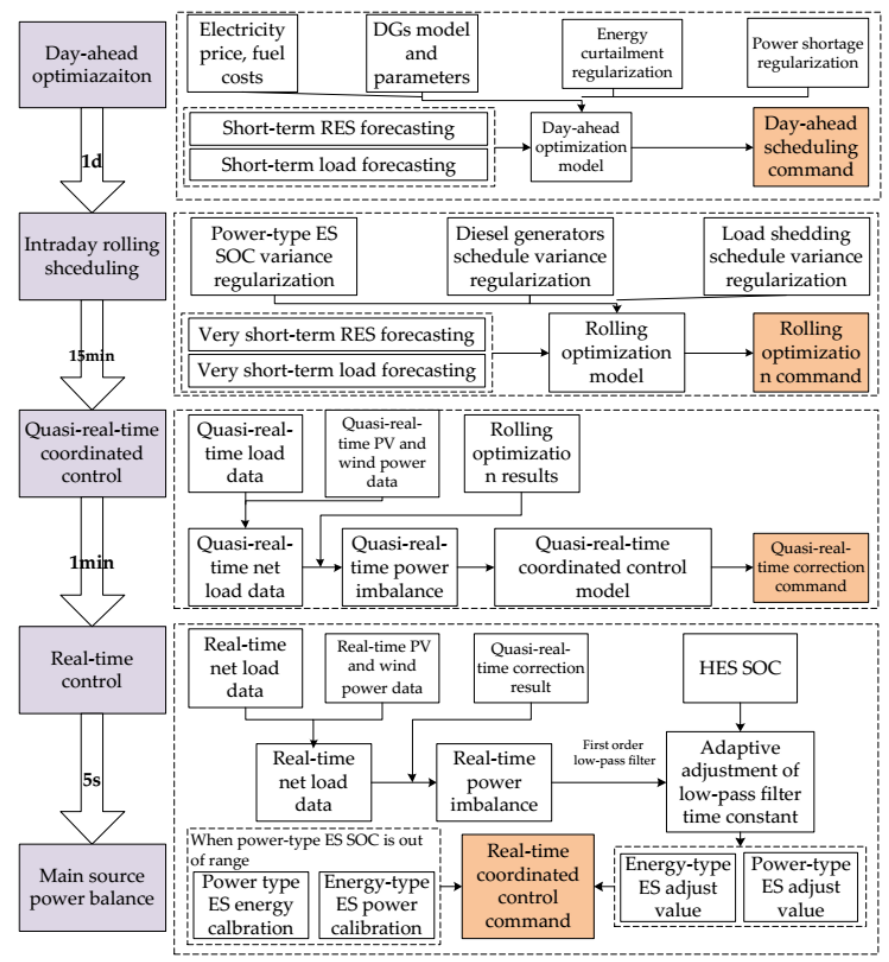
Figure 2. The framework of multi-time scale coordinated control.